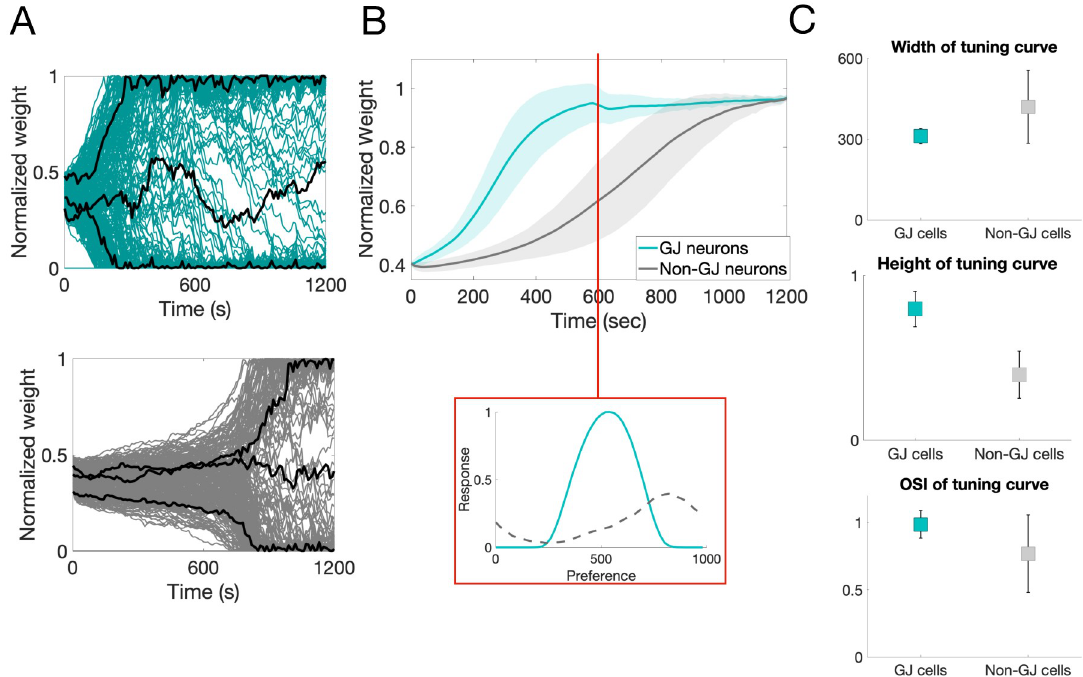
Fig 3. Rate of learning properties of GJ- vs. non-GJ-coupled cells. A : Top (bottom): Progression of the feedforward synaptic weights onto a sample GJ-coupled (non-GJ-coupled) neuron. The black curves highlight three synapses that have potentiated, depressed, and remained around an average value; B : The average weight progression (curve) and standard deviation (shaded region) for all GJ-coupled neurons (teal) and all non-GJ-coupled neurons (gray) calculated by averaging together all feedforward synapses that potentiated to at least 70% of the maximum synaptic weight over all cells in each population. Inset: Sample tuning curve for a GJ-coupled neuron (solid) and a non-GJ-coupled neuron (dashed) after 600 seconds of simulation time, before recurrent connections begin to form. C : Width and height of the tuning curves measured for all cells in the network, as well as the orientation-selectivity index (OSI), the average reported as the center of each square, the standard deviation as error bars, over all cells in each group.